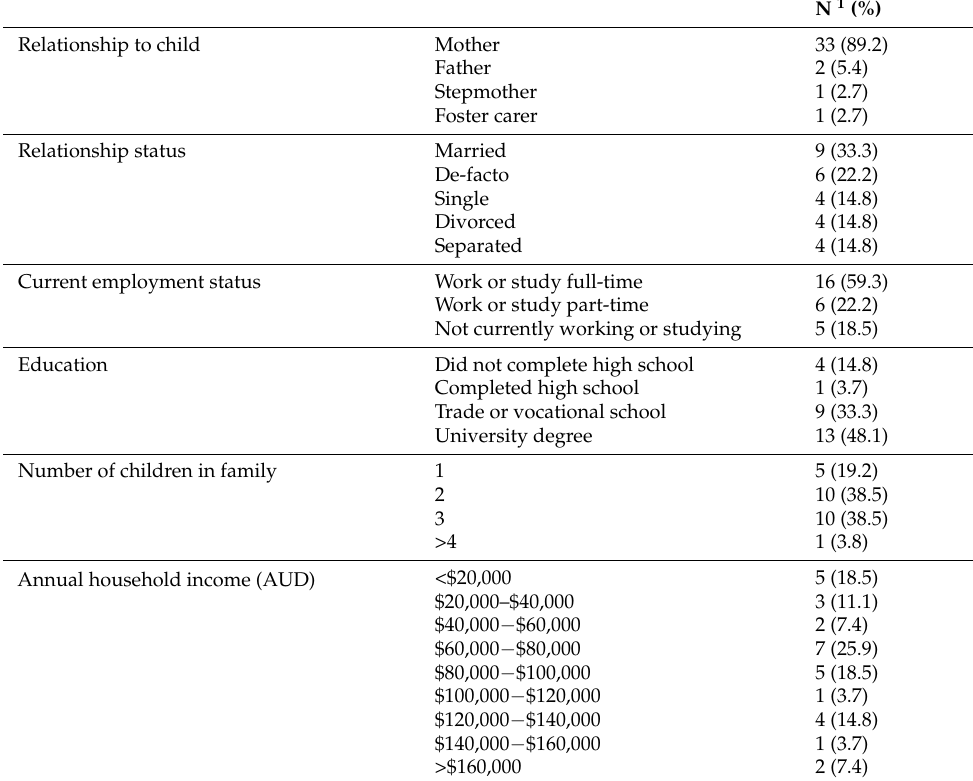
Table 1. Demographic and clinical